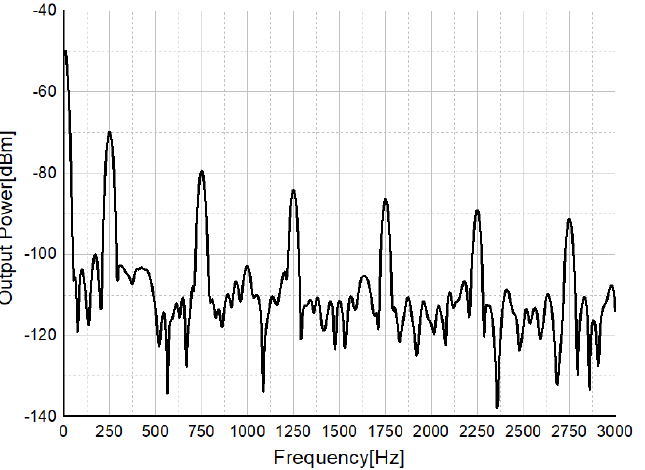
Figure 49. Measurement result of a stationary target using pulse mode with a hovering